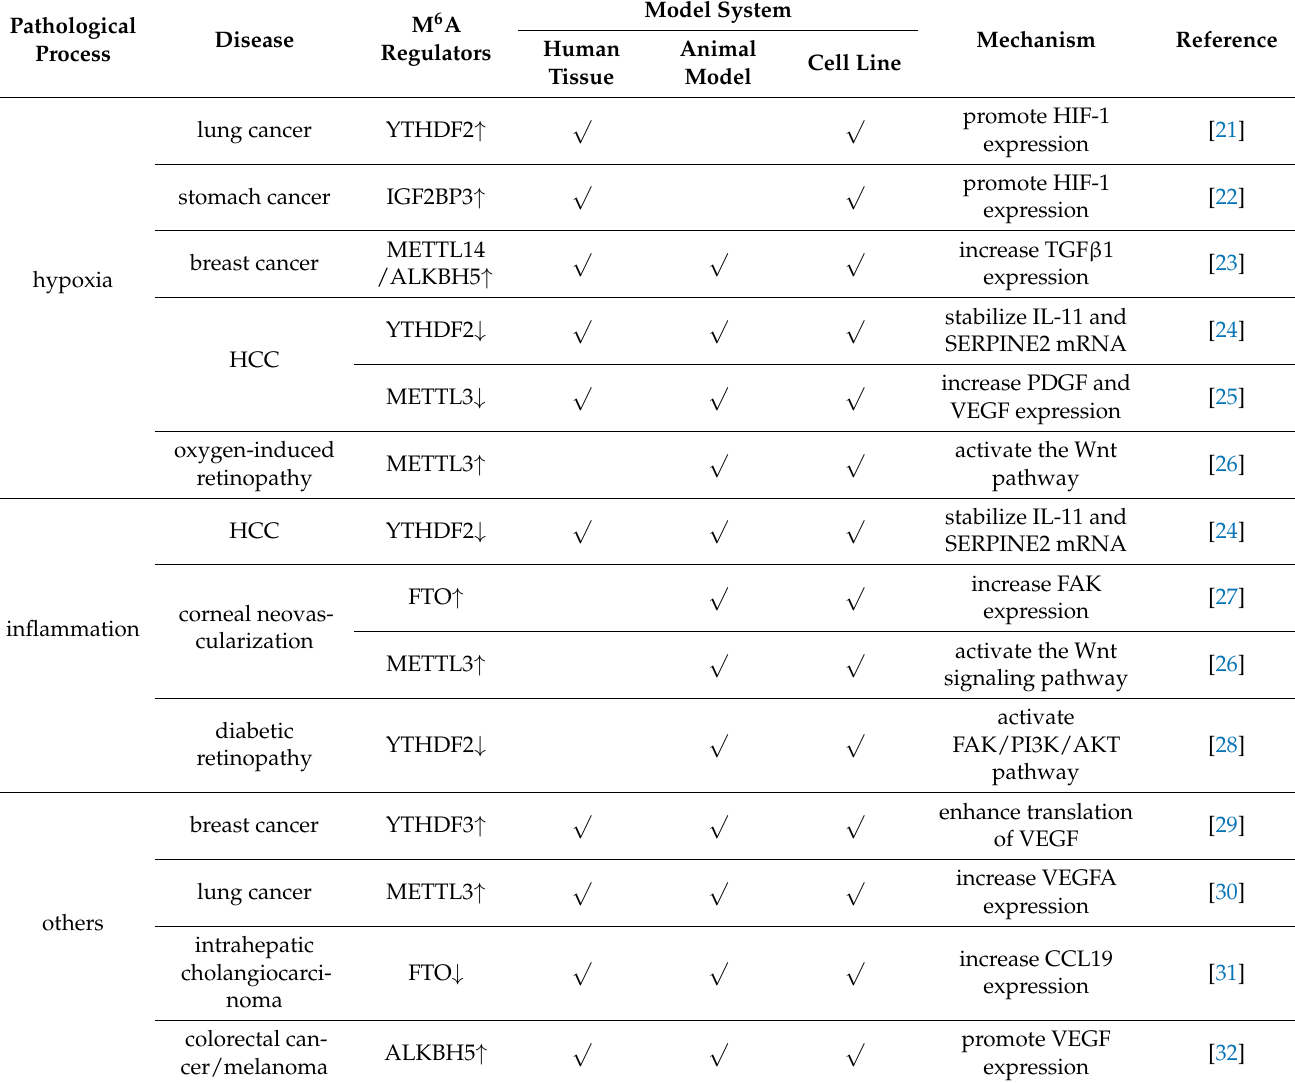
Table 1. Molecular mechanisms of m 6 A modification in pathological